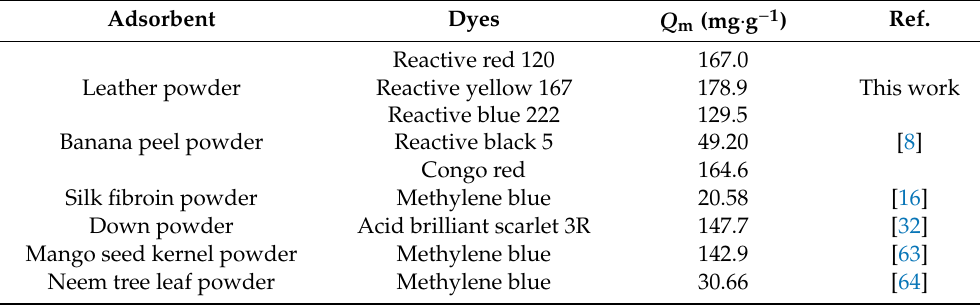
Table 3. Maximum adsorption capacity ( Q m ) of dyes onto the powders.